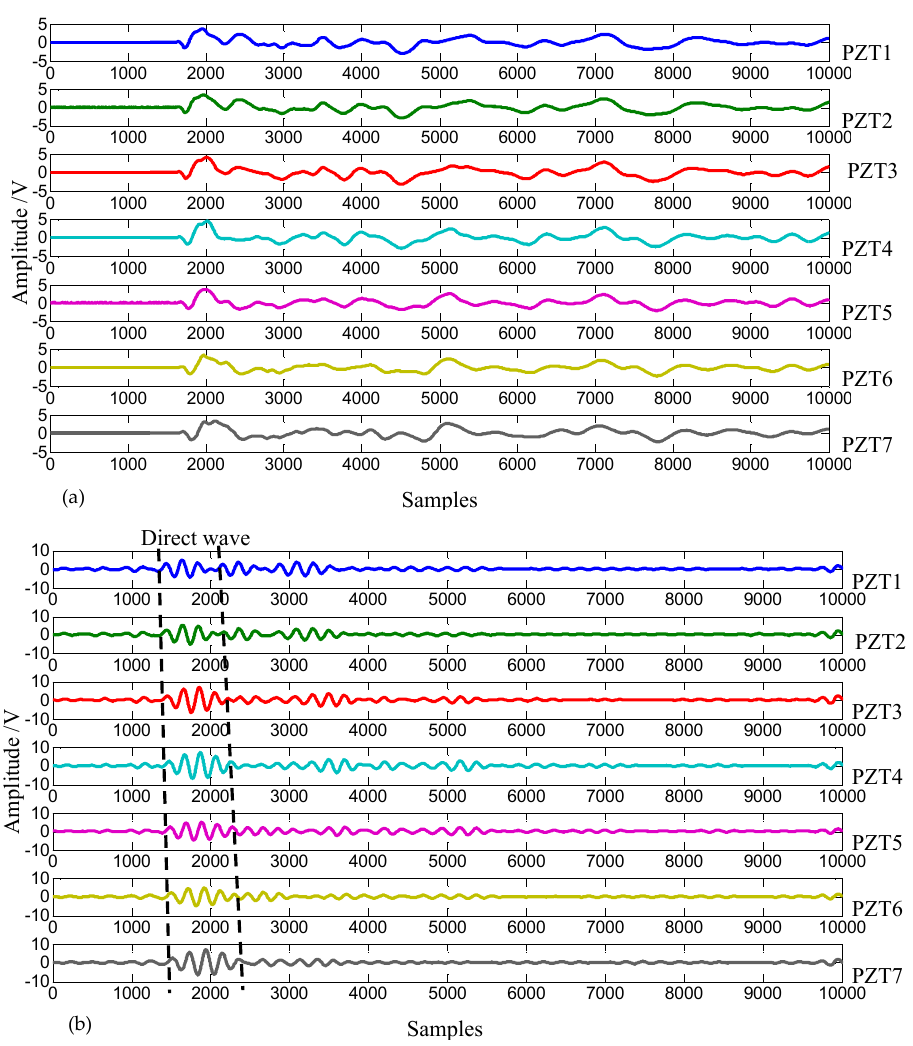
Figure 7. ( a ) Respond array signals of case#1 and ( b ) its narrow band signals extracted.